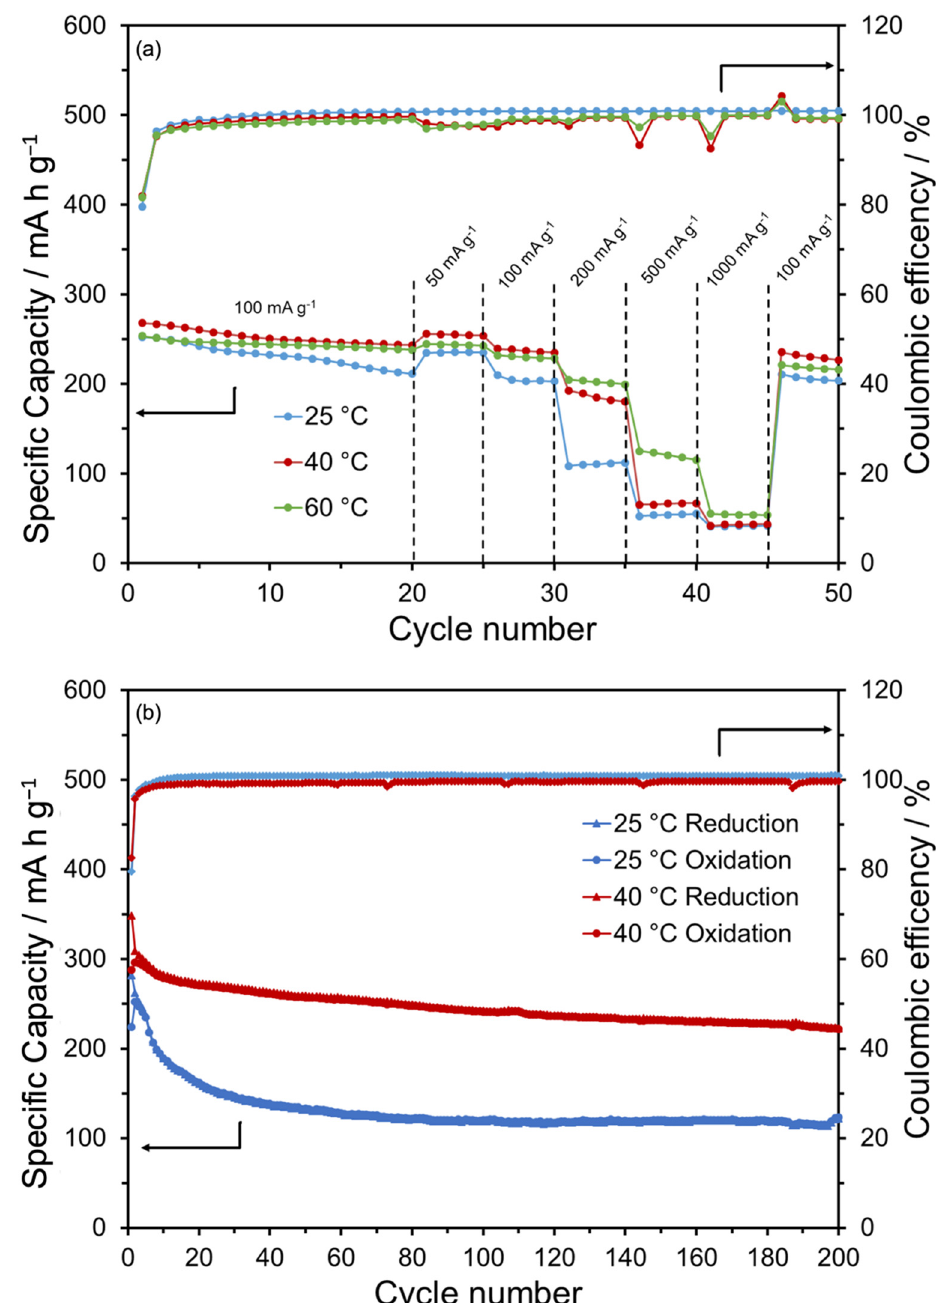
Figure 9. ( a ) Rate capability of HC oxidation capacity and Coulombic efficiency at different current densities with various temperatures of 25, 40 and 60 °C, ( b ) long-term cycling stability and Coulombic efficiency of HC with 25 and 40 °C.